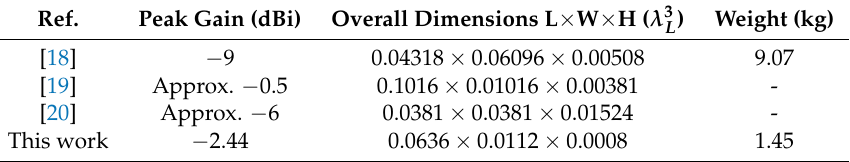
Table 2. Performance comparison with a previous VHF antenna.